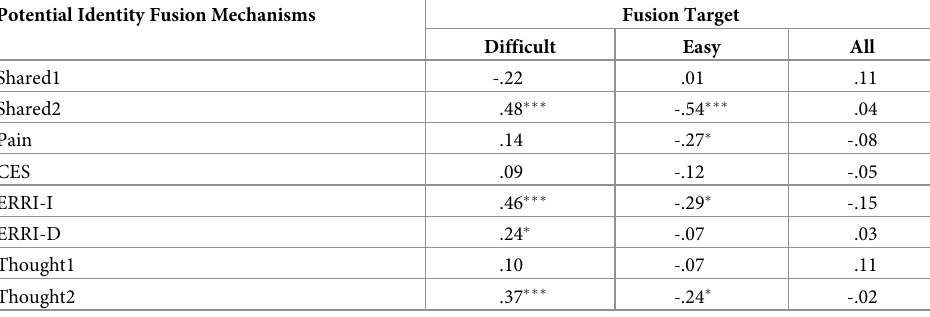
Table 4. Pearson correlations between potential mechanisms and the three fusion targets.